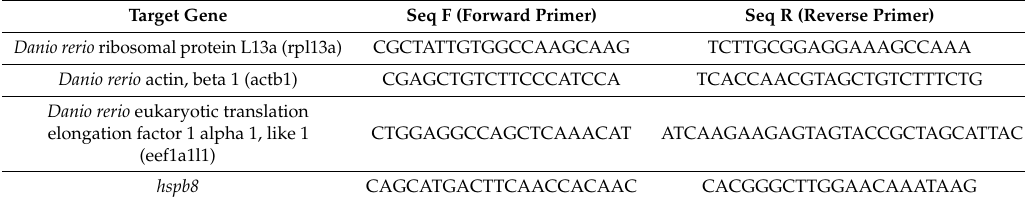
Table 1. The sequences of gene-specific primers used in the real-time quantitative PCR analyses. Target Gene Seq F (Forward